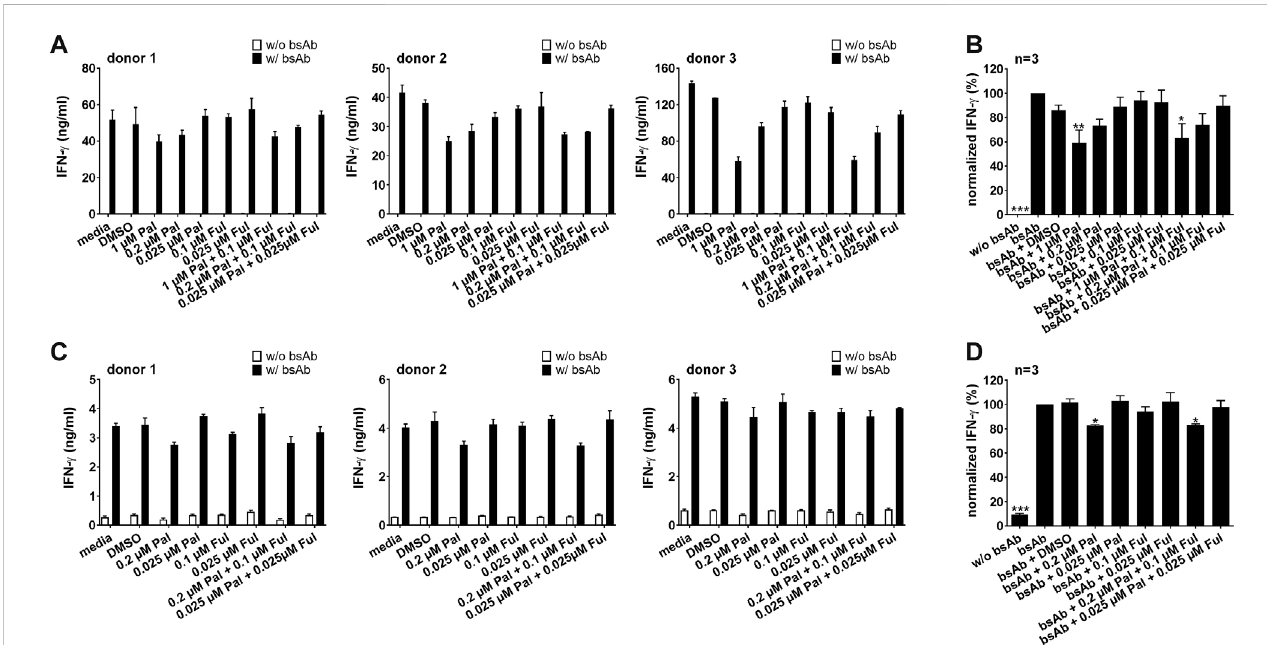
FIGURE 5 Effect of palbociclib and fulvestrant on IFN- γ release of bsAb-engaged T cells. T cells and (A,B) PC3-PSCA/PSMA Luc+ or (C,D) LNCaP-PSCA Luc+ cells wereincubatedwithorwithout30 nMofCD3-PSCAbsAbinthepresenceorabsenceofpalbocicliband/orfulvestrant.After96 h,IFN- γ concentrationsinco- culture supernatants were analyzed by ELISA. (A,C) Each diagram shows average IFN- γ concentration ± SEM of triplicates for one T cell donor. (B,D) Graphs summarize relative IFN- γ release ± SEM of three different T cell donors. IFN- γ concentrations in the presence of T cells, tumor cells and bsAb ( “ bsAb ” ) were equalized to 100%. (* p ≤ 0.05, *** p ≤ 0.001 compared to control sample “ bsAb ” ; One-way ANOVA with posthoc Dunnett multiple comparison test).